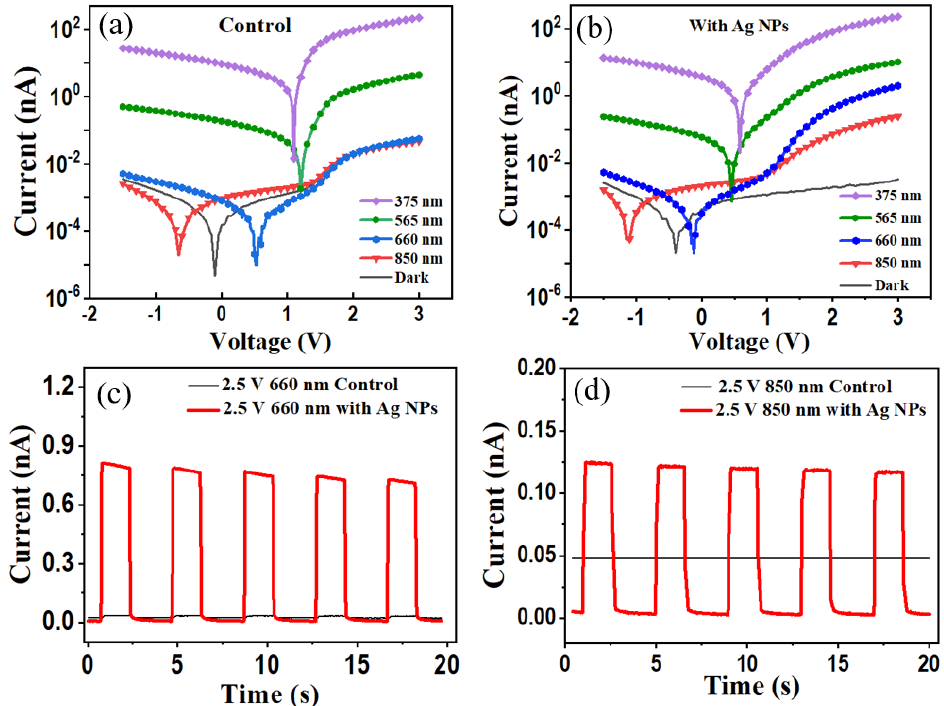
Figure 2. ( a , b ) Logarithmic I−V characteristics of the control OPD and the plasmonic OPD in the dark and under illumination at 375 nm, 565 nm, 660 nm, and 850 nm. ( c , d ) Transient current responses of different OPDs using 660 nm and 850 nm pulse LEDs as illumination sources. Thick curves with symbols in Figure 2a,b represent the log I − V characteristics of the control OPD and the plasmonic OPD under illumination at different wavelengths of 375 nm (rectangles), 565 nm (circles), 660 nm (diamonds), and 850 nm (triangles), with the incident power density of 13 mW/cm 2 . One can see clearly in Figure 2a that, for the control OPD, the photocurrents under biases above 1.8 V at the wavelengths of 660 nm and 850